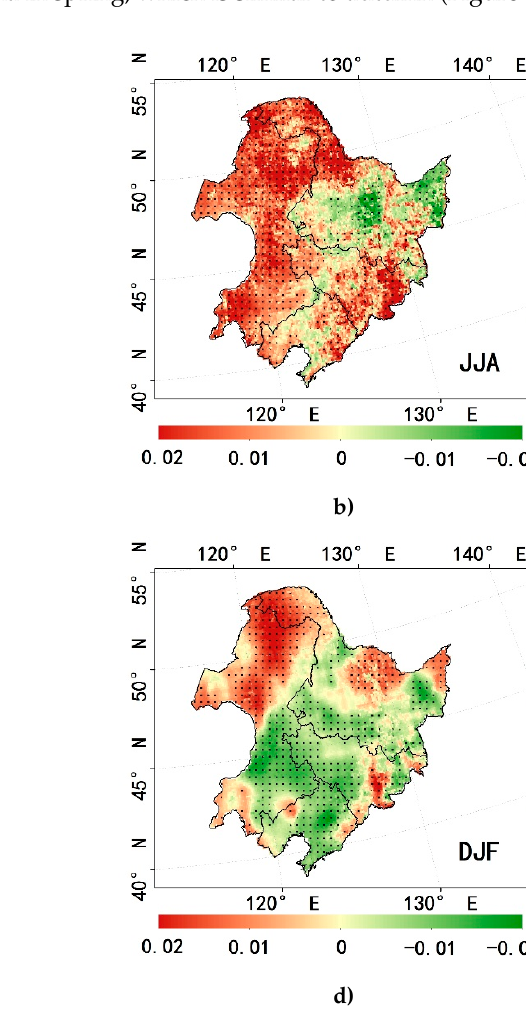
Figure 14. The seasonal trend of sEDI during 1982–2015 in Northeast China for ( a ) MAM; ( b ) JJA; ( c ) SON; ( d ) DJF. Green indicates wetter and red indicates dryer.